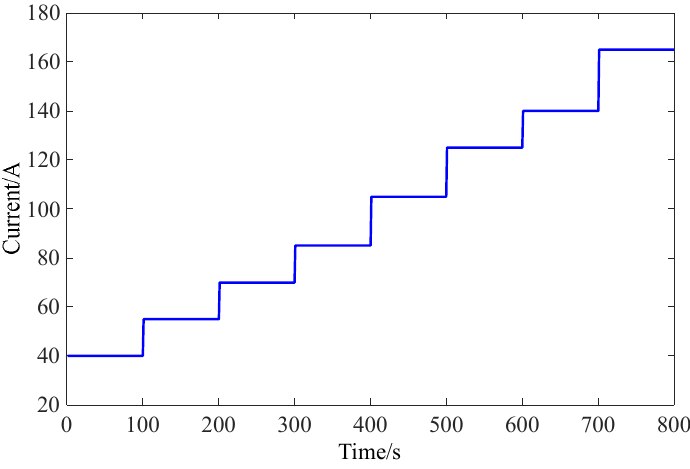
Figure 9. Load current test signal.